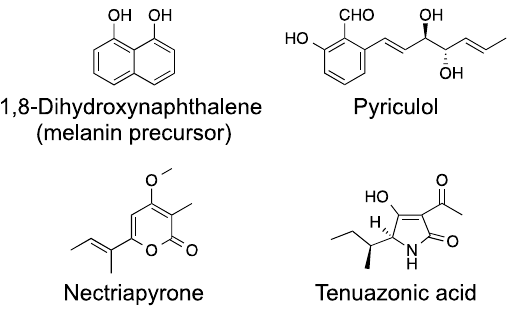
Figure 1. Chemical structures of secondary metabolites from the rice blast fungus P. oryzae .